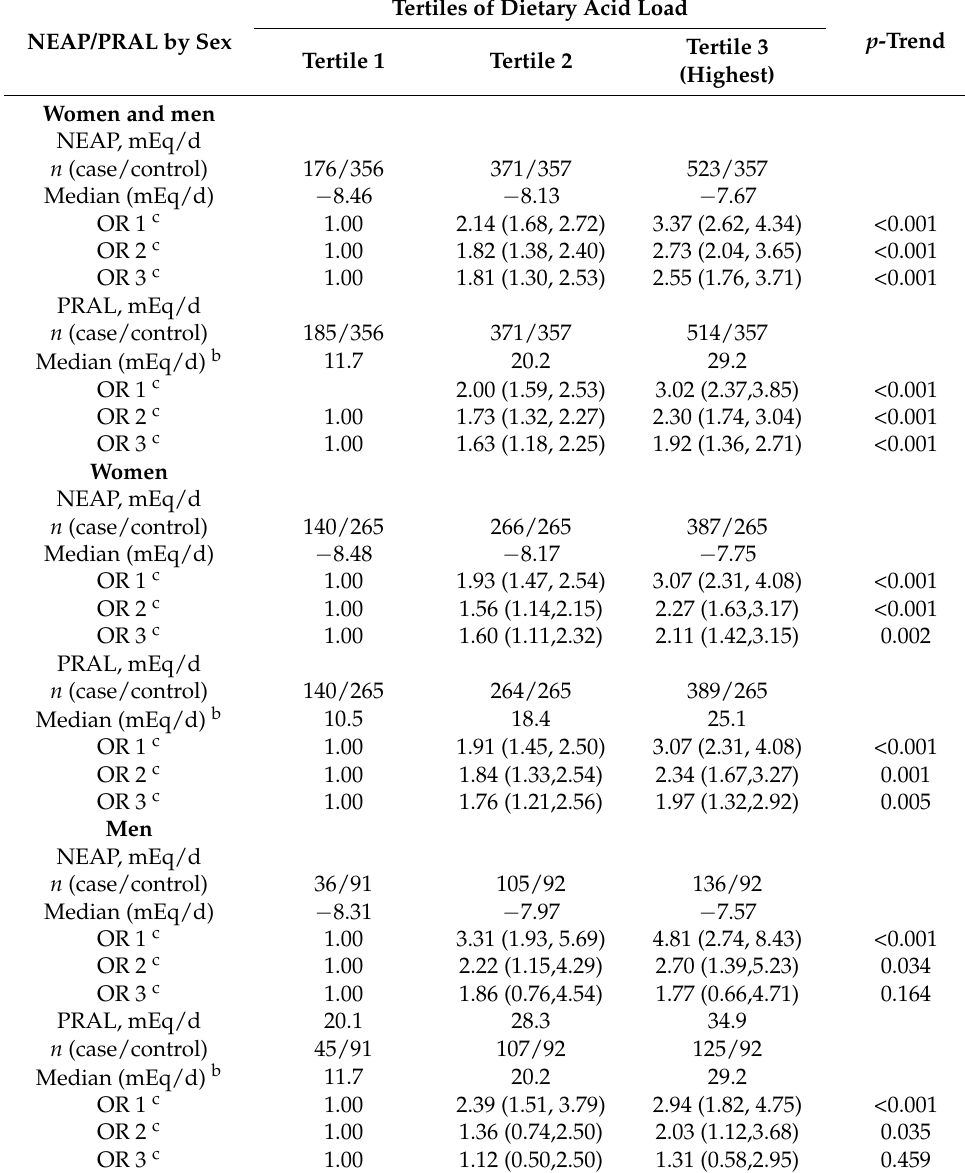
p -Trend Tertile